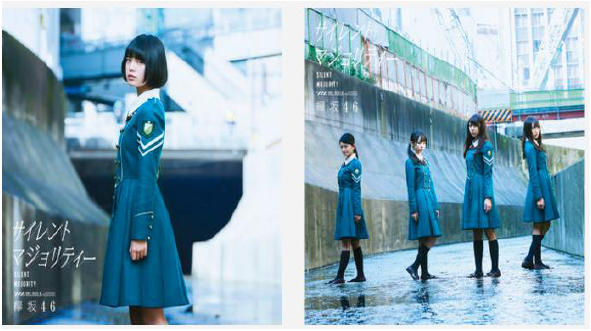
Fig. 2 Cover for Keyakizaka46’s debut single, Silent